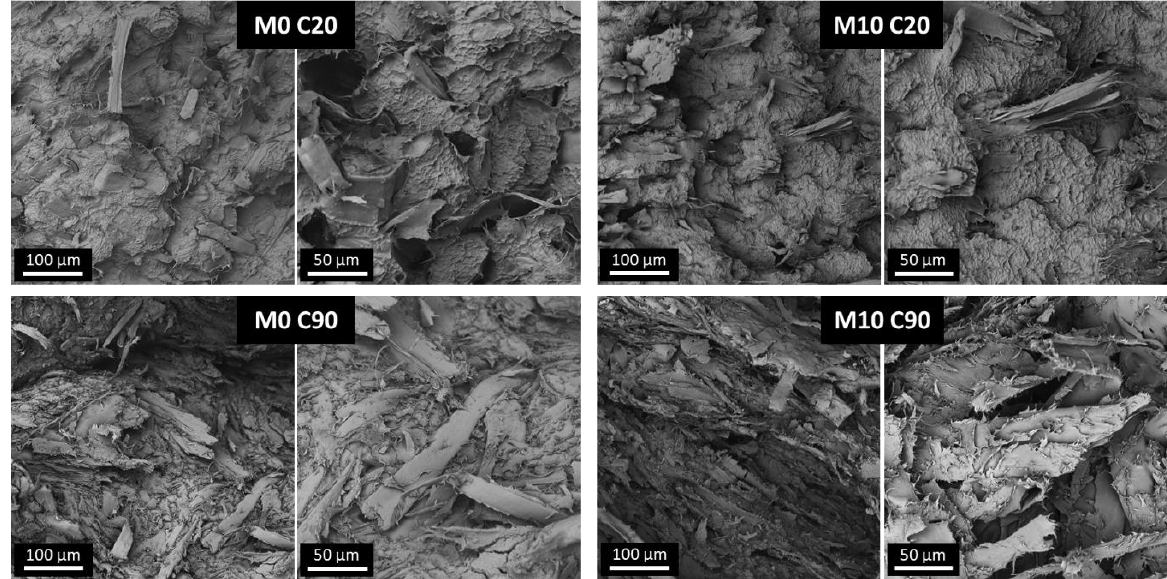
Figure 2. SEM micrographs of impact fracture surfaces of samples without (M0 C20, M0 C90) and with (M10 C20, M10 C90) coupling agent, at different magnification levels.